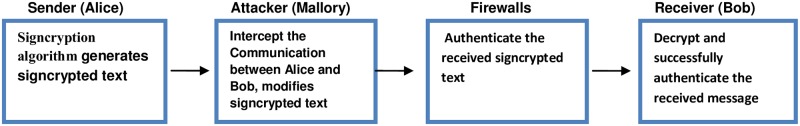
Our cryptoanalysis model.